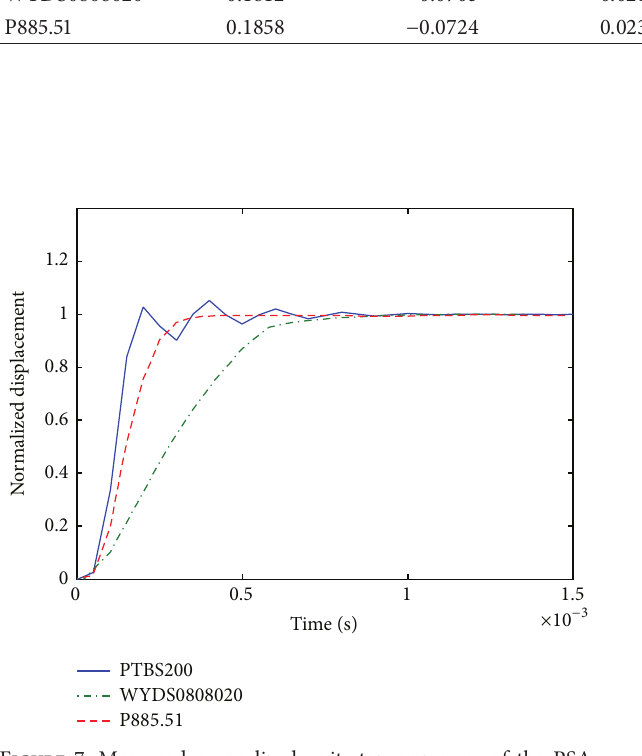
Figure 7: Measured normalized unit step responses of the PSAs fabricated by different layering/stacking